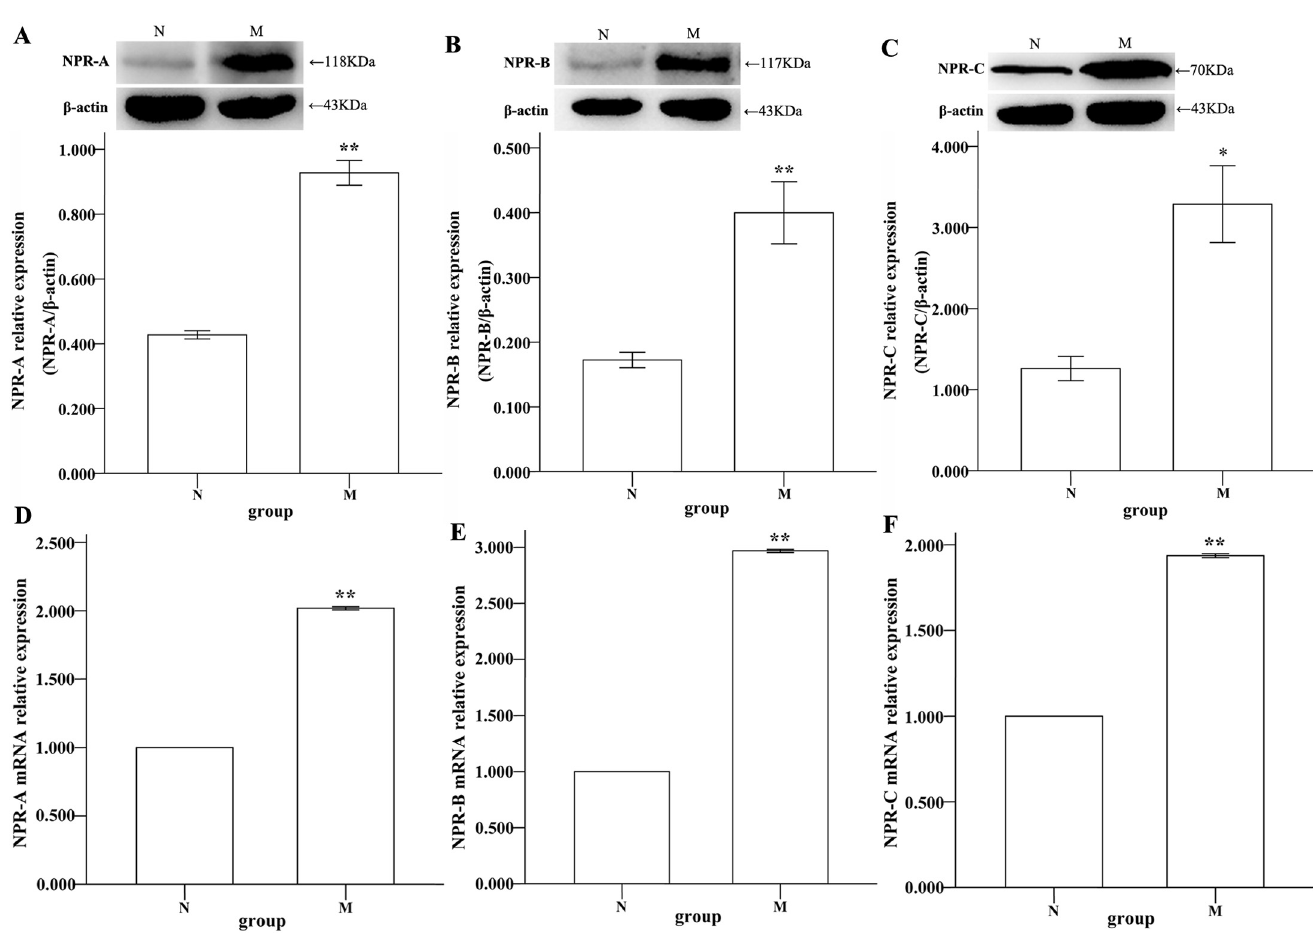
Fig 4. Western blotting and real-time PCR analyses of NPR-A, B and C in the stomachs of rats. (A-C) The ratio of NPR-A/ β -actin was 0.427 ± 0.013 in N and 0.927 ± 0.038 in M. The ratio of NPR-B/ β -actin was 0.172 ± 0.012 in N and 0.400 ± 0.048 in M. The ratio of NPR-C/ β -actin was 1.261 ± 0.151 in N and 3.287 ± 0.474 in M. The differences between M and N were significant (compared with normal, ** P < 0.01, Independent-Samples T-test, A-B; * P < 0.05, Independent- Samples T-test, C). (D-F) The result of NPR-A is 1.000 ± 0.000 in N and 2.019 ± 0.005 in M. The result of NPR-B is 1.000 ± 0.000 in N and 2.969 ± 0.012 in M. The result of NPR-C is 1.000 ± 0.000 in N and 1.936 ± 0.012 in M. The differences between N and M were significant ( ** P < 0.01, Independent-Samples T-test).